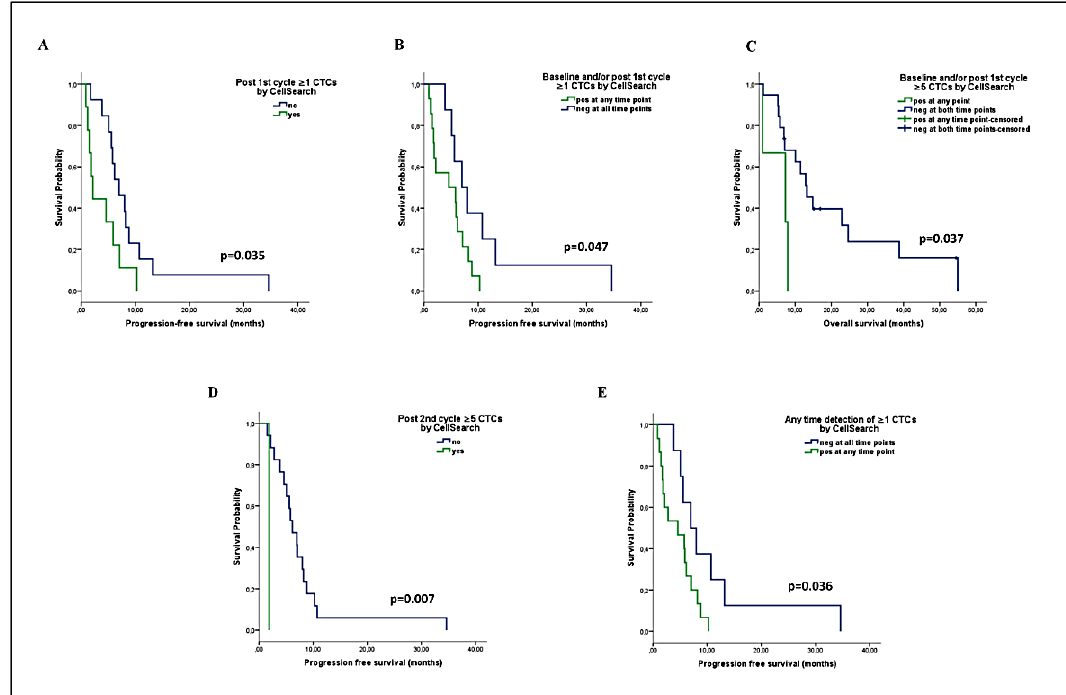
Figure 5. Prognostic relevance of the kinetics of CTCs detected by CellSearch during first-line chemotherapy in patients with advanced NSCLC. ( A ) PFS analysis according to CTC detection post-1st cycle of treatment, ( B , C ) PFS and OS rates according to the combined CTC status at baseline and/or post-1st cycle of treatment, ( D ) PFS analysis according to CTC detection post-2nd cycle, ( E ) PFS according to the combined CTC status at any of the three time points among baseline, post-1st cycle, and post-2nd cycle.